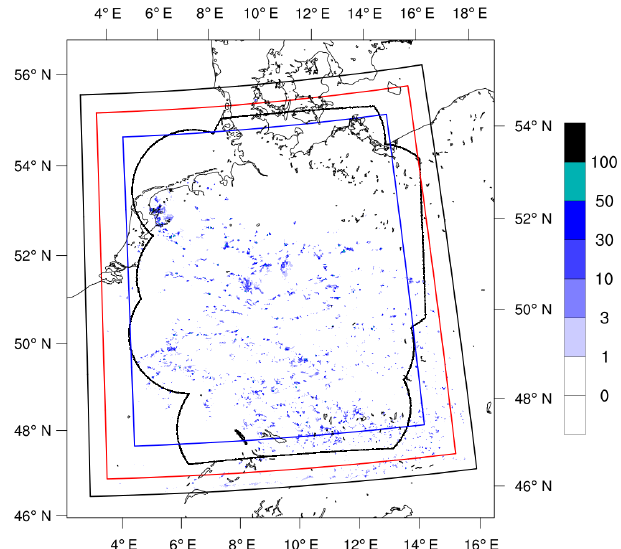
Figure 1. Simulation domain. The black frame shows the extent of the outer domain 1 with 625m grid spacing, and the red and blue frames show the nested domains 2 and 3 with 312 and 156m grid spacing, respectively. The black contour shows the maximum extent of the RADOLAN dataset. Color shading shows the surface precip- itation field on 3 June 2016, at 14:00UTC, simulated on the outer domain with 625m grid spacing, given in millimeters per